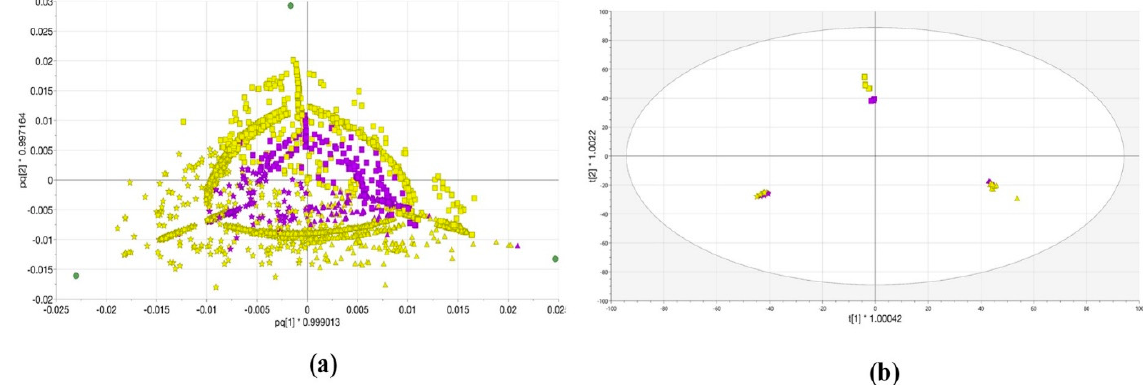
Figure 3. ( a ) The loading plot displays the relation between the different Lemna minor samples 100% MeOH (triangular), 50% MeOH (stars), and 100% H 2 O (squares) extracts analyzed with TOF-MS (violet) and QTOF-MS/MS (yellow); ( b ) OPLS-DA score scatter plot of Lemna minor samples with 95% confidence limit.